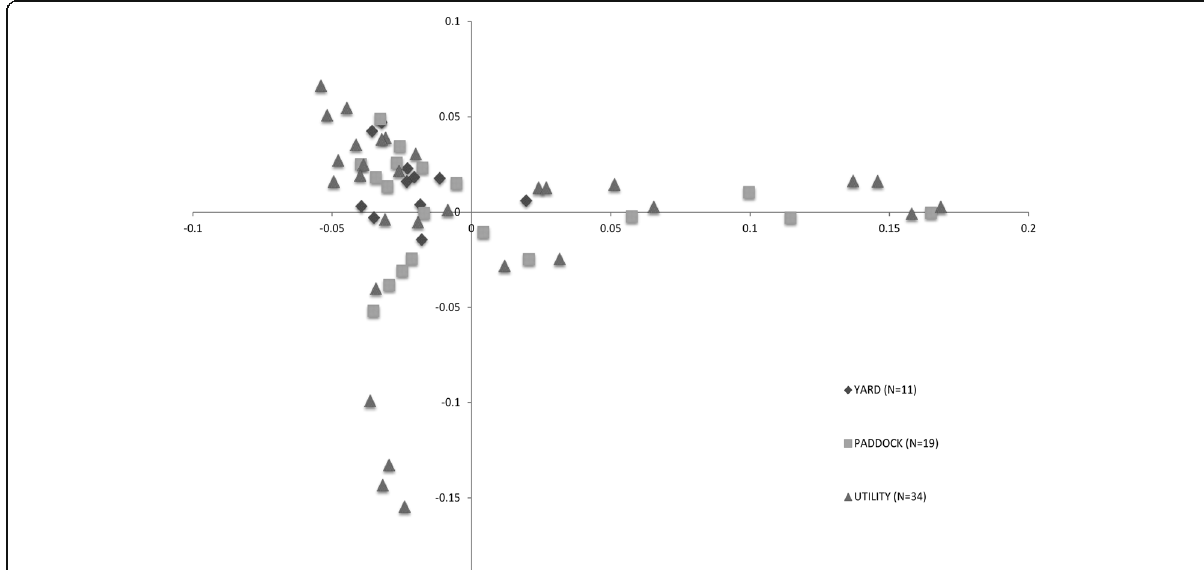
Fig. 2 Multi-dimensional scaling plot displaying genetic distances between individuals from Australian Working Kelpie populations described as Paddock , Yard and Utility working types demonstrating that there is no clear genetic differentiation between the working types (Table S3). (Legend: Paddock ( N = 19) – square marker; Yard ( N = 11) – diamond marker; Utility ( N = 34) – triangular